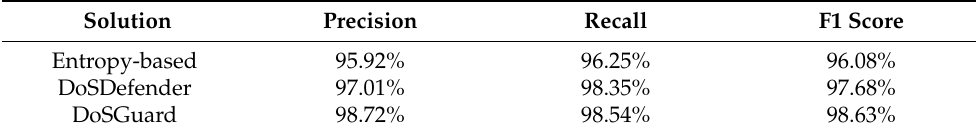
Table 4. Results of different detection